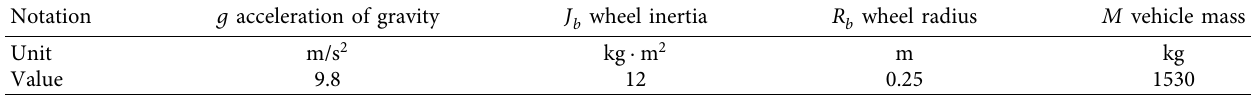
Table 1: Parameters used in simulations.